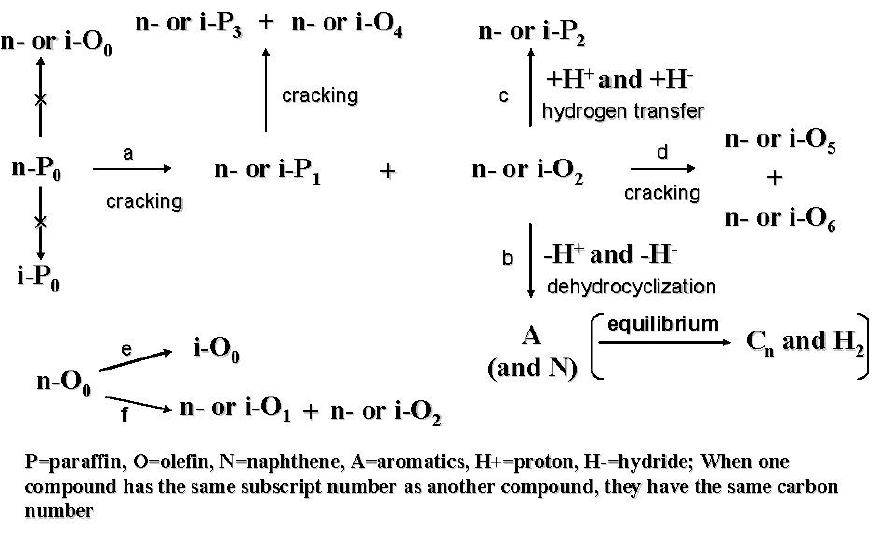
Figure 13. Reaction pathways in catalytic cracking of n